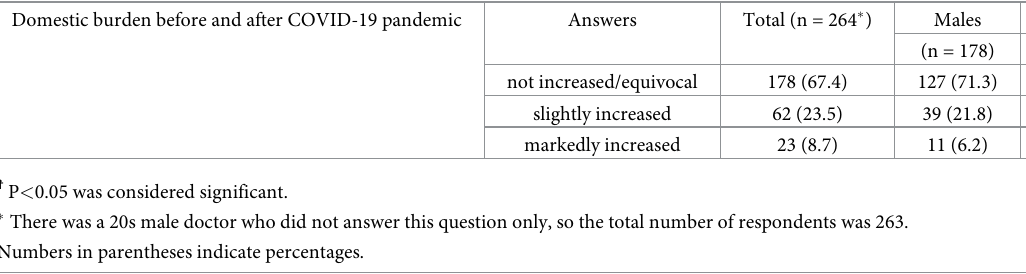
(8.7%) answered that the domestic burden was slightly or markedly increased, respectively (Table 2). The increase was found for both genders. However, regarding a marked increase of the domestic burden associated with the pandemic, the ratio of female physicians with such an increase was significantly higher than that of male physicians (not or equivocal/slight/marked